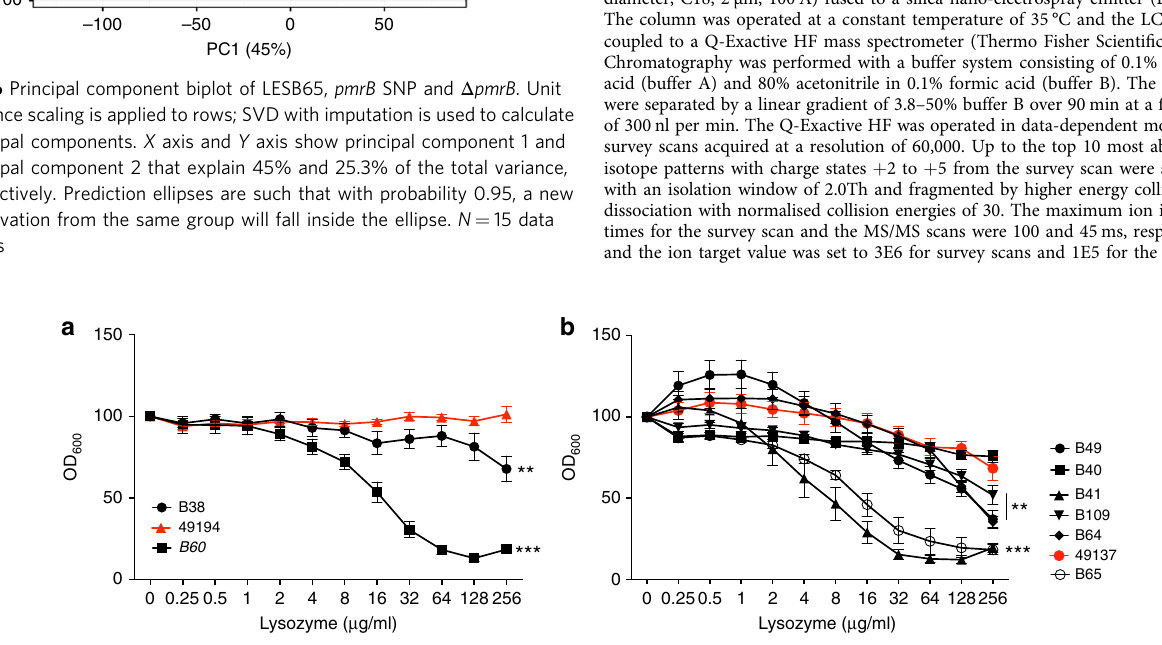
Fig. 7 pmrB mutations are found in patient isolates and are associated with lysozyme resistance. Three isolates from one patient ( a ) and seven from another ( b ) were compared for lysozyme resistance. Isolates with at least one pmrB mutation are in red (49194 = R202H, 49137 = I73L, E82K, E225Q). ( a , b ) Growth in the presence of lysozyme expressed as a percentage of growth in LB (OD 600 ). Data are presented as mean ± s.d. and are a composite of three independent experiments with each isolate run in triplicate. ** p < 0.01, *** p < 0.005, ns non-signi fi cant, vs. 49194 ( a ) or 49137 ( b ) in ANOVA analysis performed on OD 600 with lysozyme as a